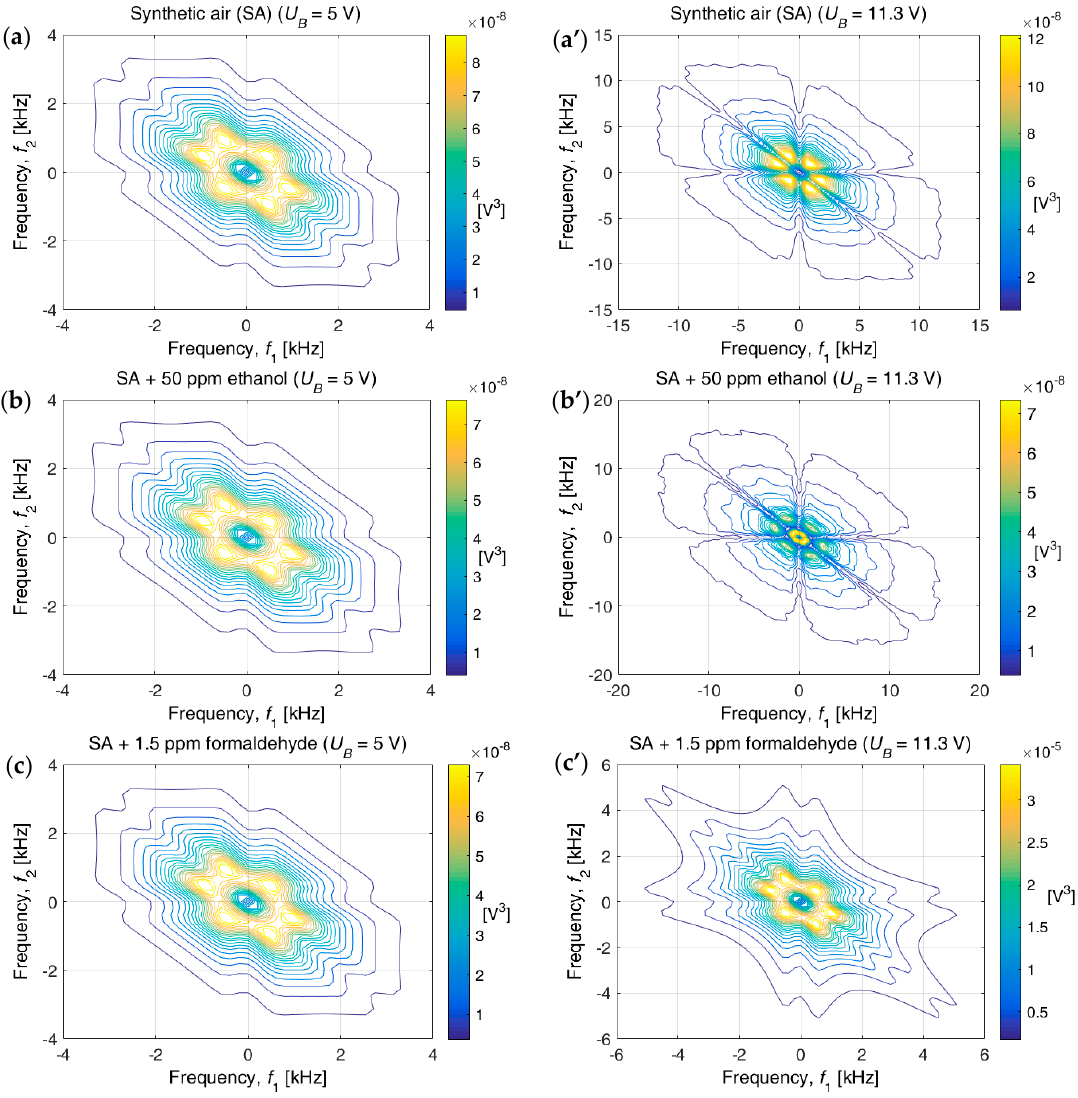
Figure 4. Two-dimensional contour plots of the bispectrum function for voltage fluctuations recorded across an AuNP-based gas sensor exposed to the shown gases at the stated bias voltages ( U B ). In each panel, the curves indicate equally-spaced color-coded constant values of the bispectrum function; they represent magnitudes ranging from a low limit (blue) to a high limit (yellow). Actual values of these limits are indicated by the colored vertical bars in the respective panels